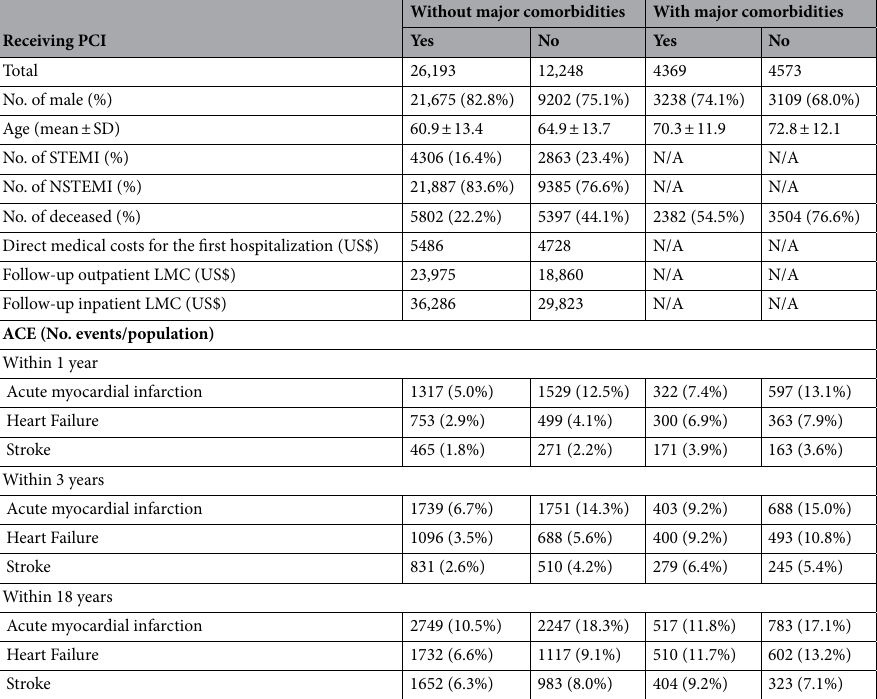
Table 1. Demographic characteristics of patients with acute myocardial infarction who later developed adverse cardiovascular events (ACE) and direct medical costs for the first hospitalization, life-time medical costs (LMC) for in- and out-patient stratified by major comorbidities and receiving percutaneous coronary intervention (PCI). Major comorbidities include ischemic stroke, hemorrhagic stroke, chronic kidney diseases, liver cirrhosis, chronic obstructive pulmonary diseases, and documental malignancy. SD standard deviation, STEMI ST-segment elevation myocardial infarction, NSTEMI non ST-segment elevation myocardial infarction.